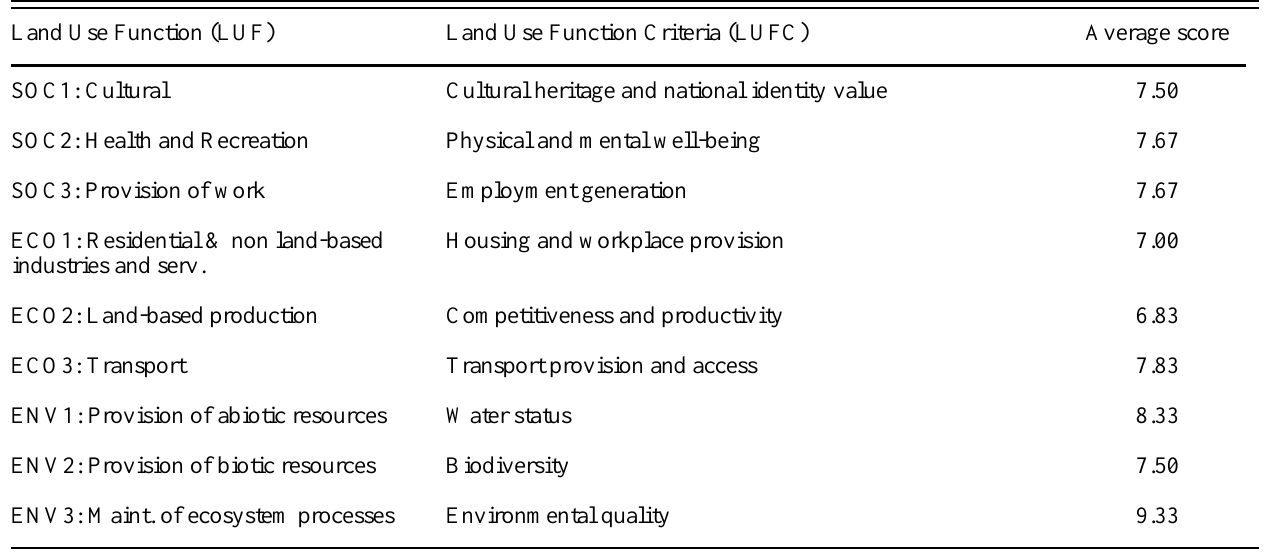
Table 3 . Definition and analysis of LUFC in Malta Land Use Function (LUF) Land Use Function Criteria